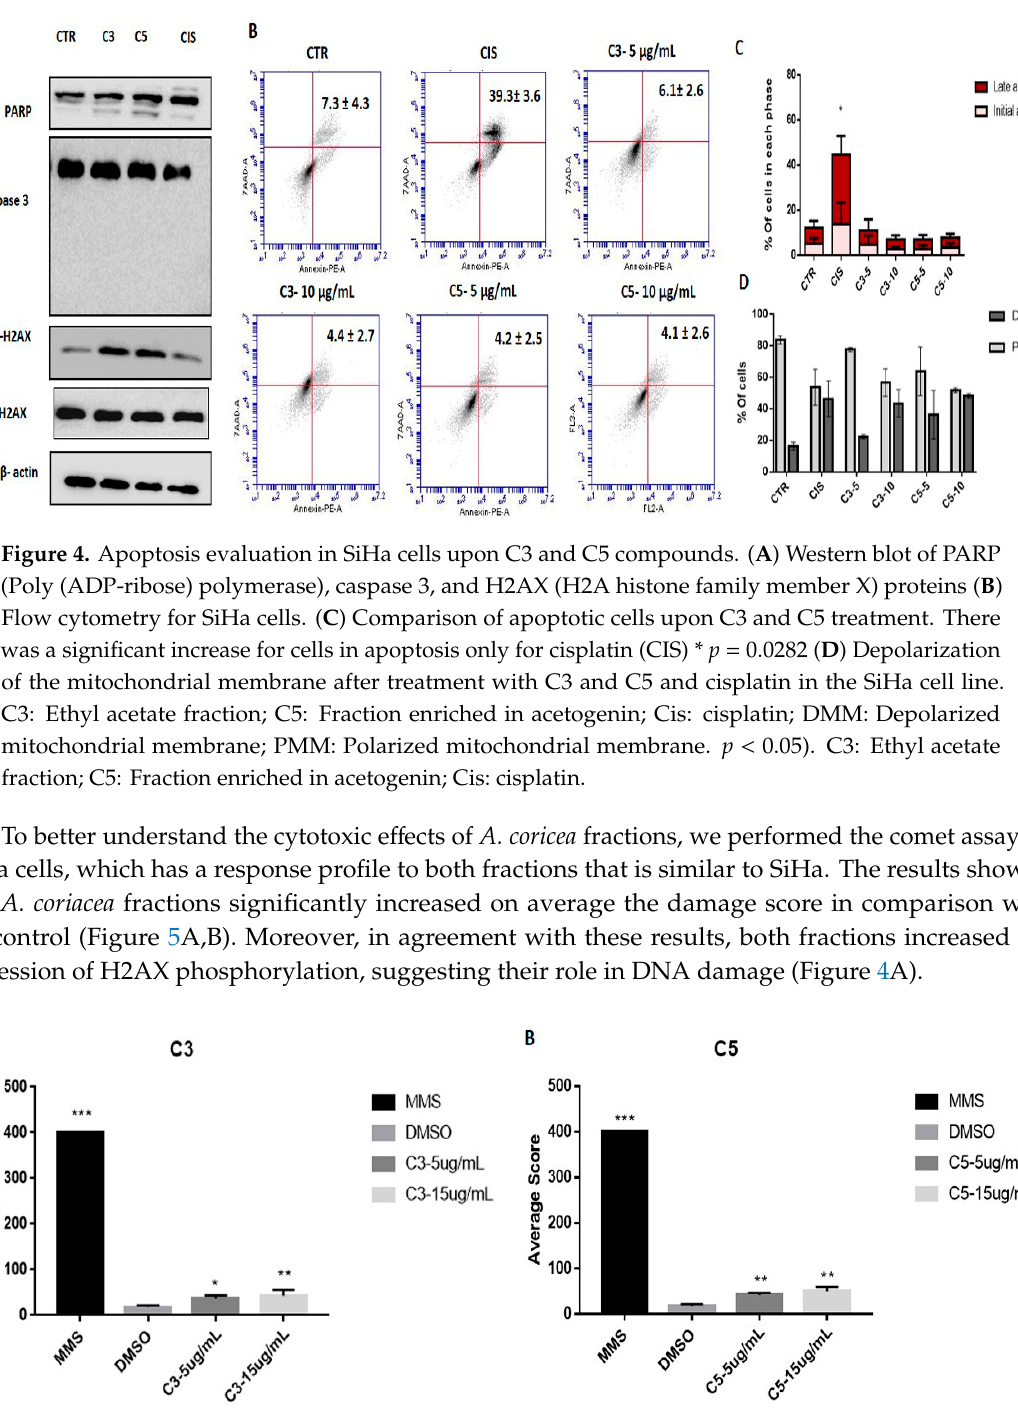
Figure 5. DNA damage evaluation in HeLa cells upon C3 and C5 compounds. ( A ) Genotoxic damage induced by C3. ( B ) Genotoxic damage induced by C5. Data are representative of three experiments. Error bars represent SD. C3: Ethyl acetate fraction; C5: Fraction enriched in acetogenin; Cis: cisplatin; MMS: Methyl methane sulphonate, DMSO: dimethylsulfoxide. *** p < 0.0001; ** p < 0.01, * p < 0.05).